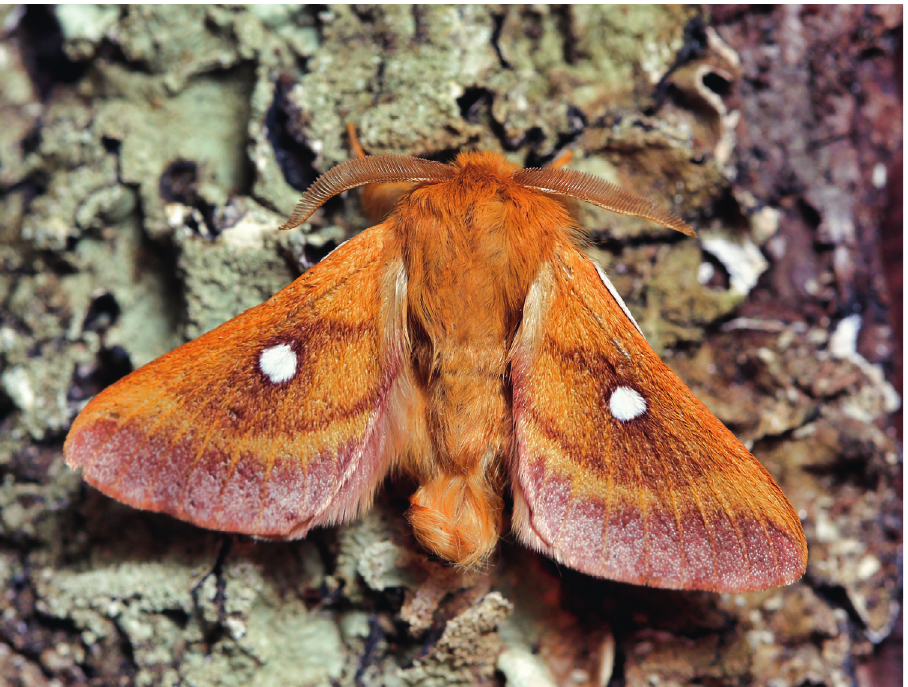
Figure 2. Eriogaster catax ,